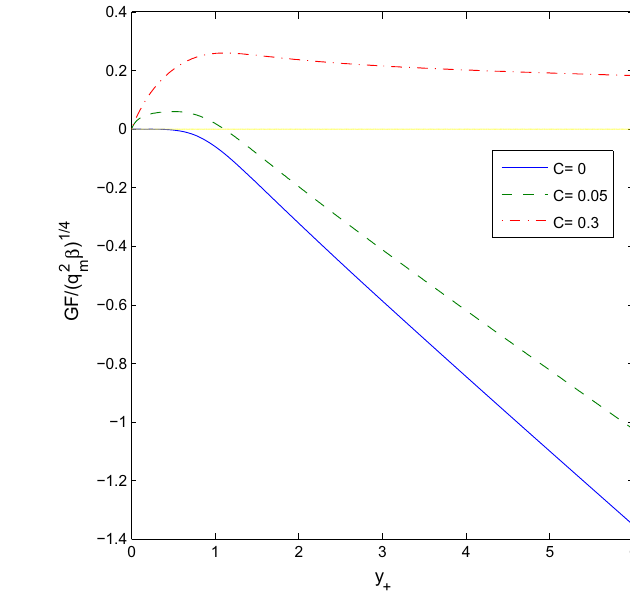
√ q m β 1 / 4 ) vs y + . The dashed